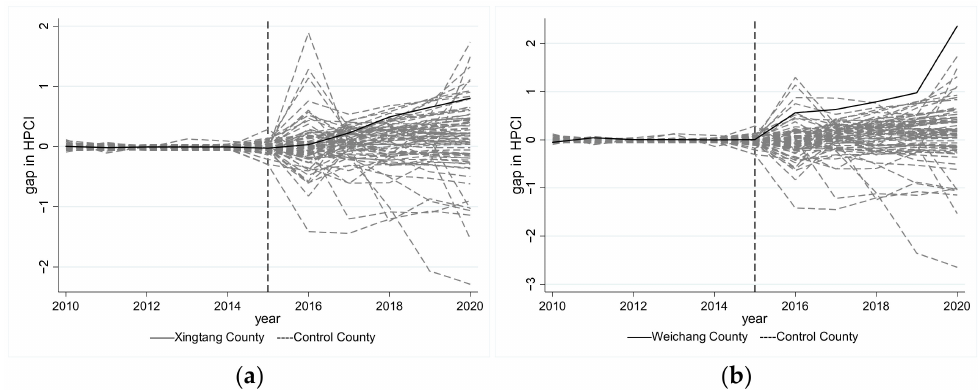
Figure 8. Herbivorous livestock industry’s concentration (HPCI) gaps in all sample points, ( a ) when Xingtang County is the treatment group, ( b ) when Weichang County is the treatment